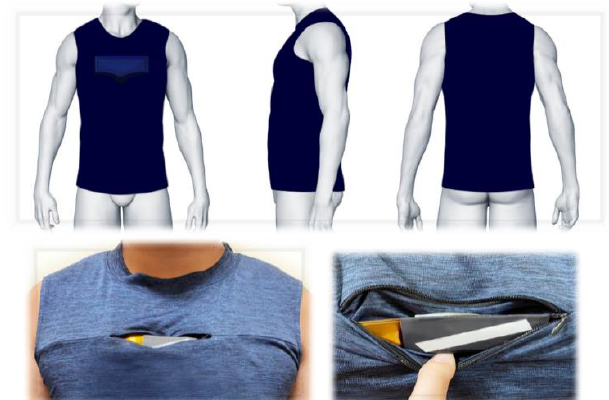
Figure 8. Simulation and photograph of smart clothes design based on parameterized 3D human body.